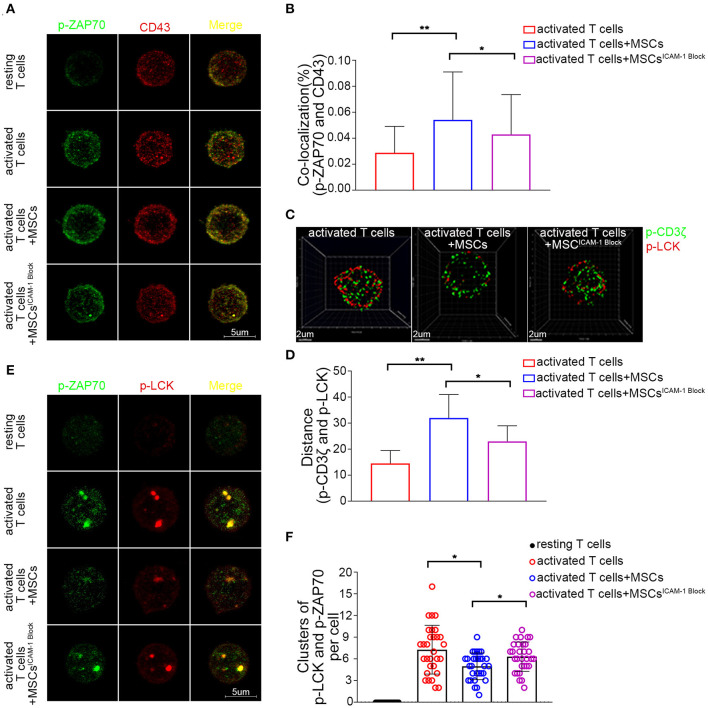
CD43-mediated TCR microcluster formation in activated T cells is rapidly altered by MSCs coculture through MSCs-derived ICAM-1. (A) Resting and activated T cells were plated on poly-lysine coated plates, and then fixed and stained for p-Zap70 (Y319) (green) and CD43 (red). Confocal images were collected. Far right shows overlay images. Four groups were analyzed: resting T cells, activated T cells, activated T cells cocultured with MSCs and activated T cells cocultured with ICAM-1-blocked MSCs. (B) The colocalization percentage of p-ZAP70 and CD43 in activated T cells, activated T cells cocultured with MSCs and activated T cells cocultured with ICAM-1-blocked MSCs. (C) Analog images display the distribution of p-CD3ζ (green) and p-LCK (red) in activated T cells. Three groups were analyzed: activated T cells, activated T cells cocultured with MSCs and activated T cells cocultured with ICAM-1-blocked MSCs. (D) Column shows the distances between p-CD3ζ and p-LCK in activated T cells of groups described in (C). (E) Images show the distribution of microclusters of p-LCK (red) and p-ZAP70 (green) in resting and activated T cells, activated T cells cocultured with MSCs, and activated T cells cocultured with ICAM-1-blocked MSCs. Far right shows overlay images. (F) Numbers of formed p-ZAP70-containing microclusters per cell. Data are shown for the groups described in (E). The data presented are representative of a minimum of three separate experiments. Panels are representative of at least 20 cells each. Significant differences are indicated as follows: *p < 0.05 and **p < 0.01.